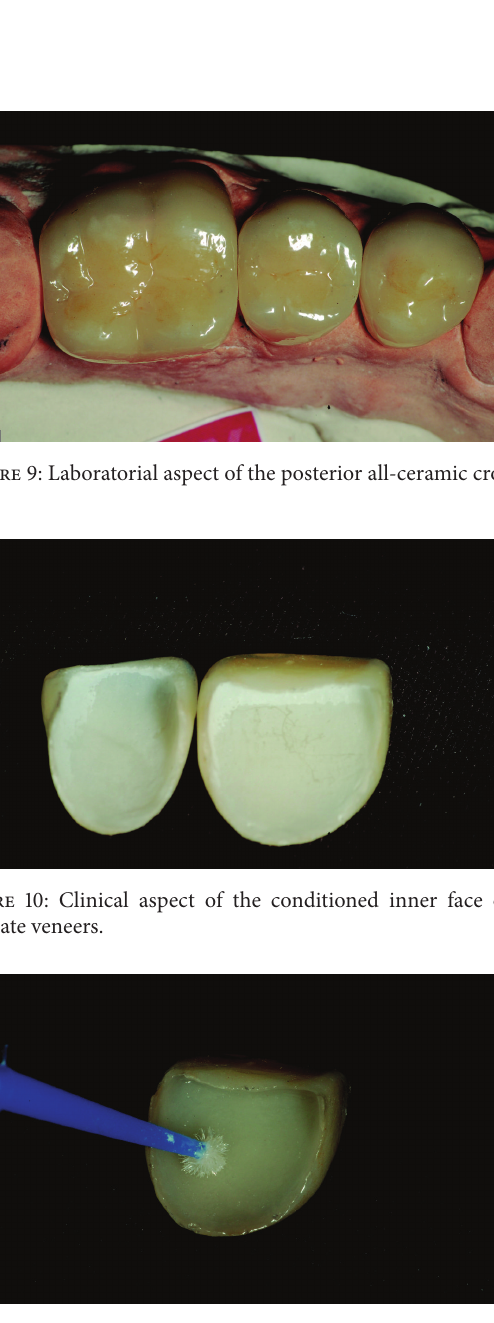
Figure 11: Clinical aspect of the conditioned inner face of